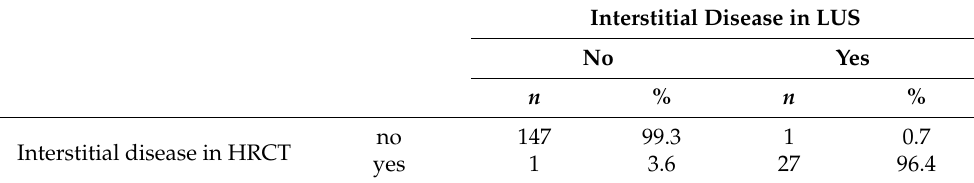
Table 4. Analysis of diagnosing ILD based on LUS and